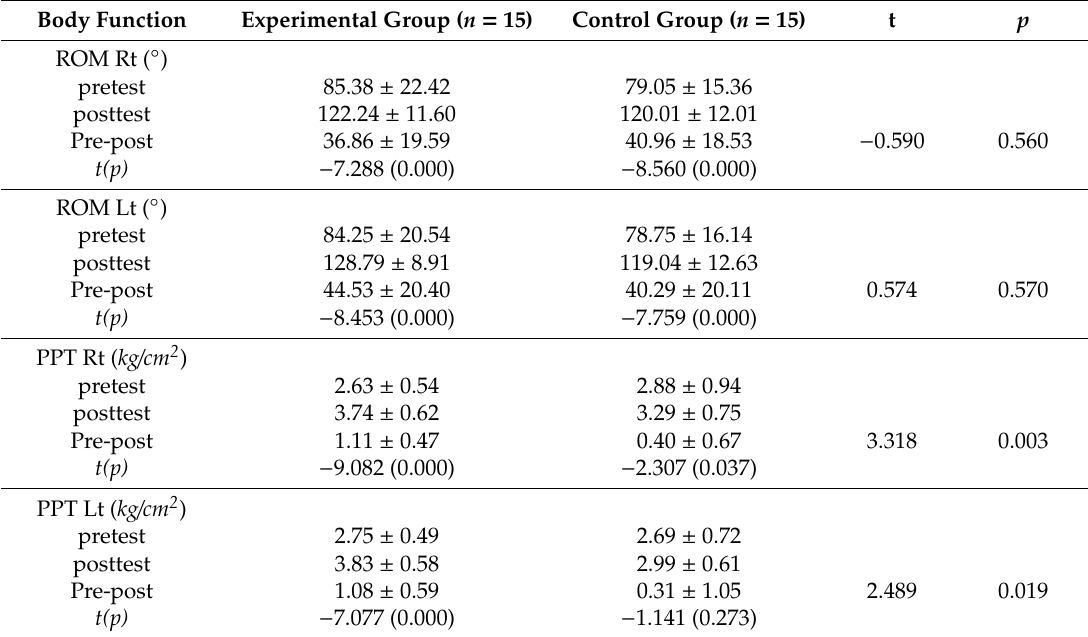
Table 3. Comparison of body function ( n =